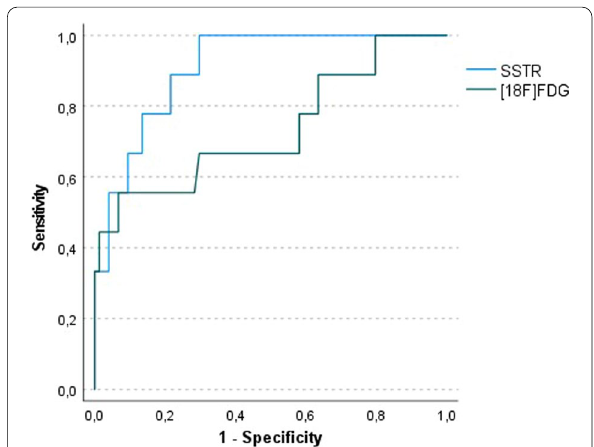
Fig. 3 ROC curve analysis of paired SUV max values of hilar/mediastinal lymph node stations of typical bronchial carcinoid tumours (TC) on SSTR PET/CT (blue curve) and [ 18 F]FDG PET/CT (green curve), yielding an area under the curve (AUC) of 0.91 and 0.74, respectively. The difference between the AUC values for SSTR and [ 18 F]FDG was 0.17 ( p =